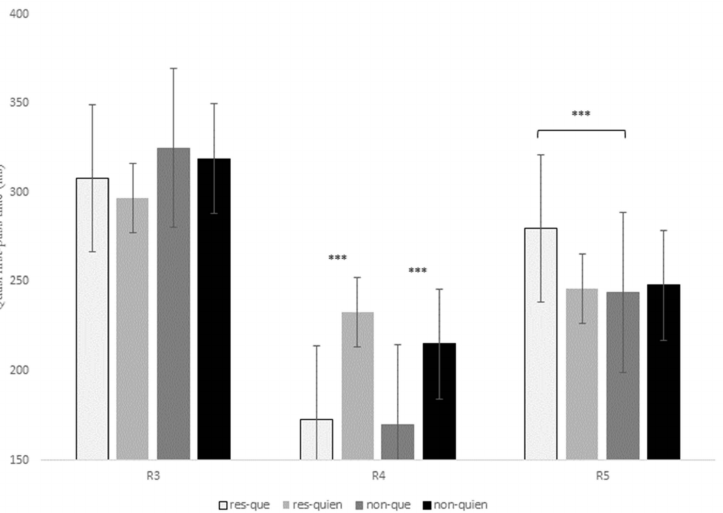
Figure 6. Reading time in milliseconds for quasi-first-pass reading times at regions 3, 4, and 5 for the contrast que versus quien in restrictive and non-restrictive RCs. Asterisks indicate that an effect is significant at p <